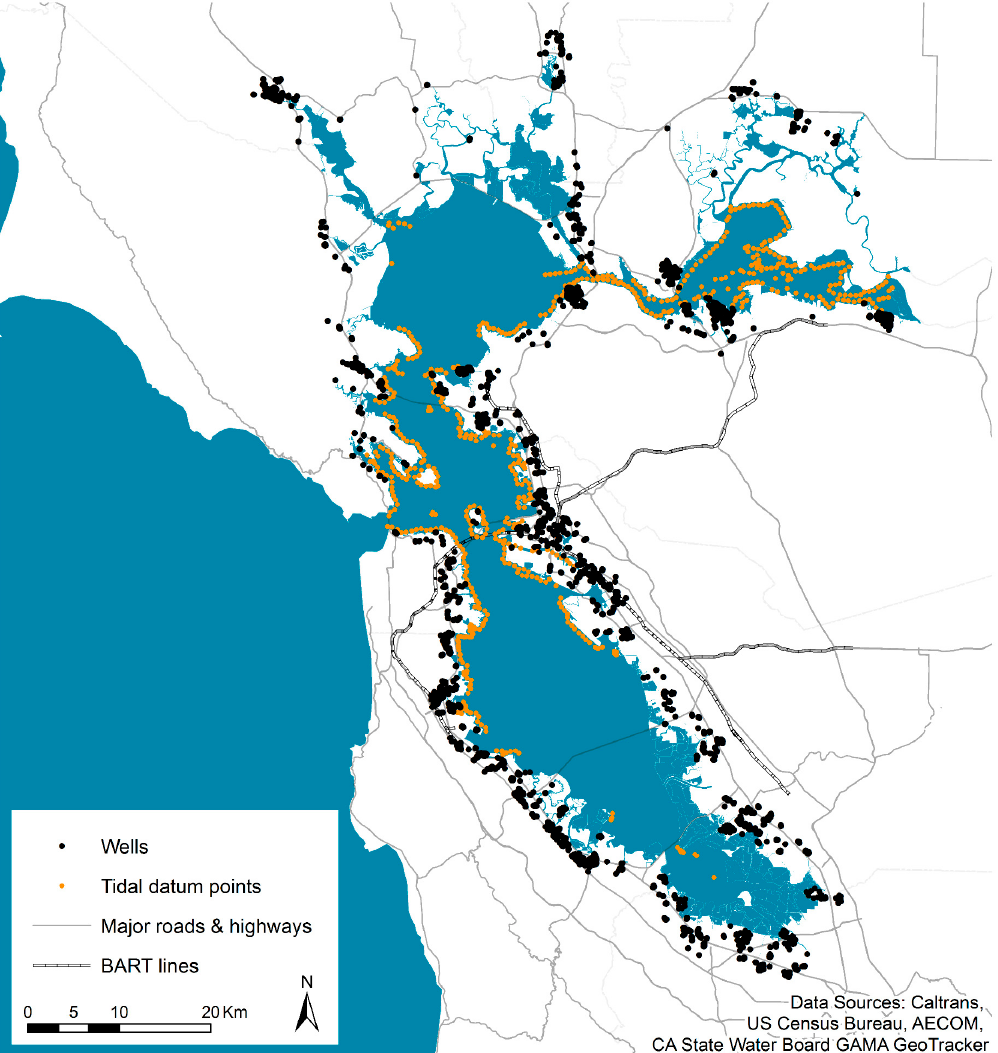
Figure 1. Well and tidal datum distribution. The highest density of data points was in the central and southern parts of the Bay Area, where more urban and industrial land uses are concentrated. Fewer wells and tidal datum measurements were available in the North Bay, where agricultural land use is more common.